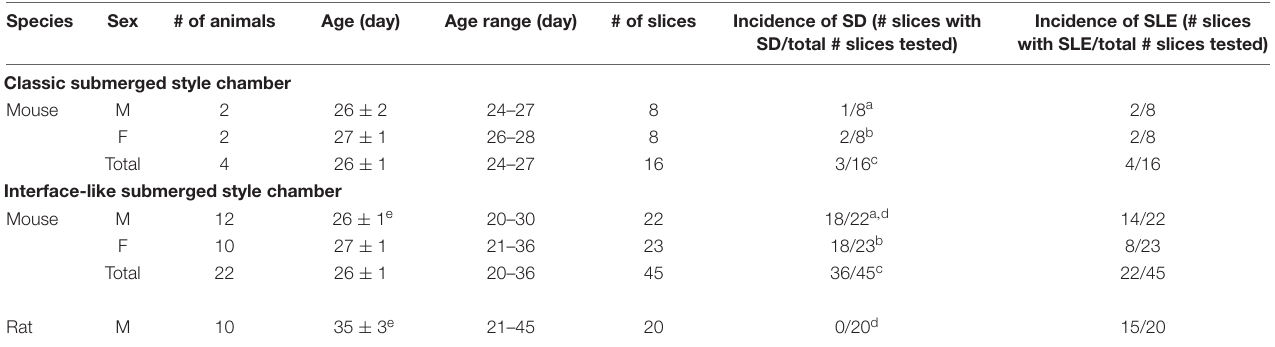
TABLE 1 | Conditions tested for the development of SD and SLEs using 0 Mg 2 + /5 K + aCSF.